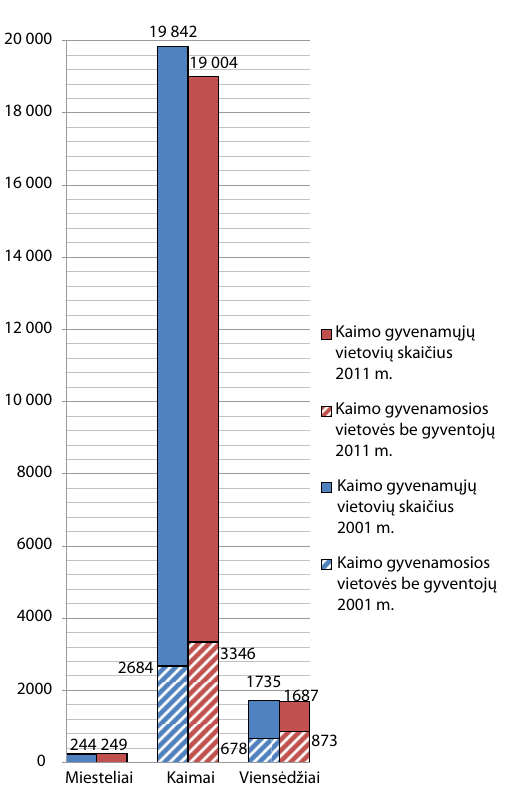
fig. 2. The number of towns in 2001-2011 (according